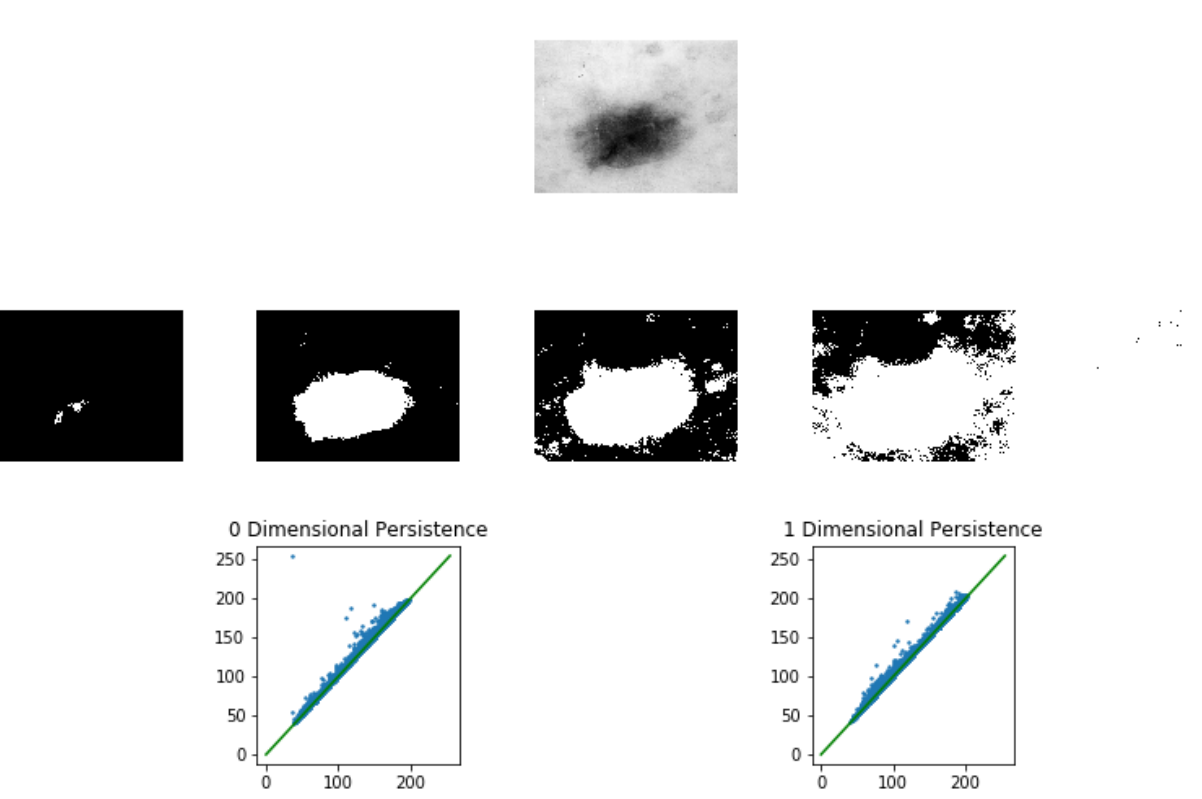
Figure 3. ( Top ): An image from the ISIC dataset. ( Middle ): A small sample of the full filtration of the top image. ( Bottom ): The 0 and 1 dimensional persistence diagrams corresponding to the full filtration of the top image. Reproduced with permission from [32]; published by IEEE,